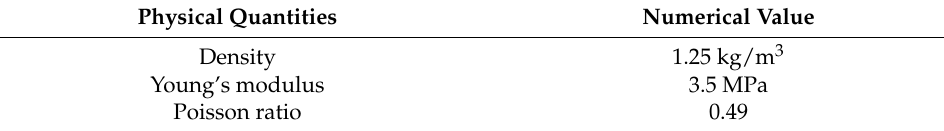
Figure 5. Leather bowl model parameters. Table 1. Physical parameters of sealing cup.